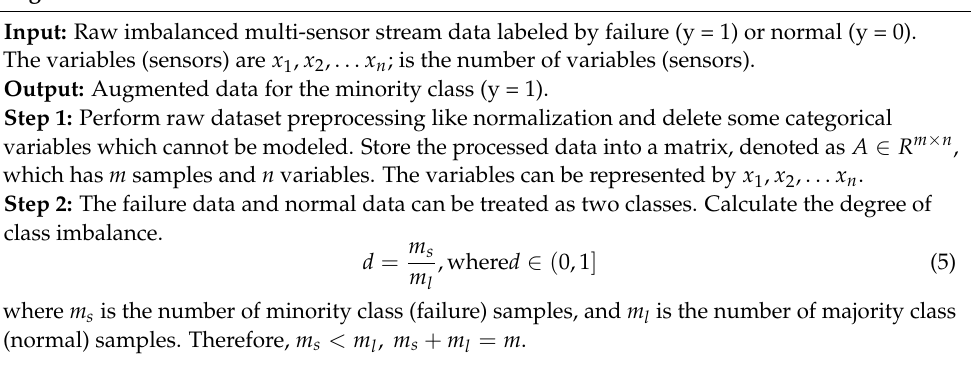
Algorithm 1: The method of